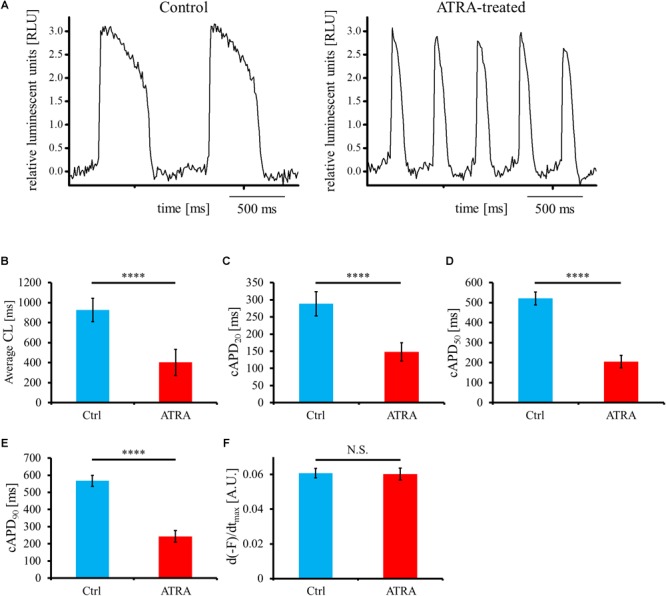
(A) Representative OAP morphology in control (left panel) and ATRA-treated hiPSC-CMs (right panel). Time scale bar, 500 ms. RLU, relative luminescent units. (B–F) Optical action potential (OAP) parameters including average CL (B), cAPD20
(C), cAPD50
(D), cAPD90
(E), and d(-F)/dtmax
(F) using voltage-sensitive dye between control and ATRA-treated hiPSC-CMs. Data are presented as the means ± SD. n = 9 (ctrl) vs. 8 (ATRA). N.S., not significant. ∗∗∗∗P < 0.0001 for control hiPSC-CMs vs. ATRA-treated CMs. A.U., arbitrary unit; Ctrl, control hiPSC-CMs (ATRA-untreated hiPSC-CMs); ATRA, ATRA-treated hiPSC-CMs.